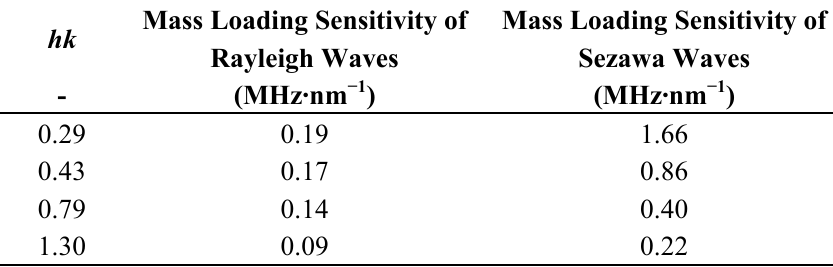
Table 3. Estimated mass loading sensitivities of Rayleigh and Sezawa waves for PMMA film